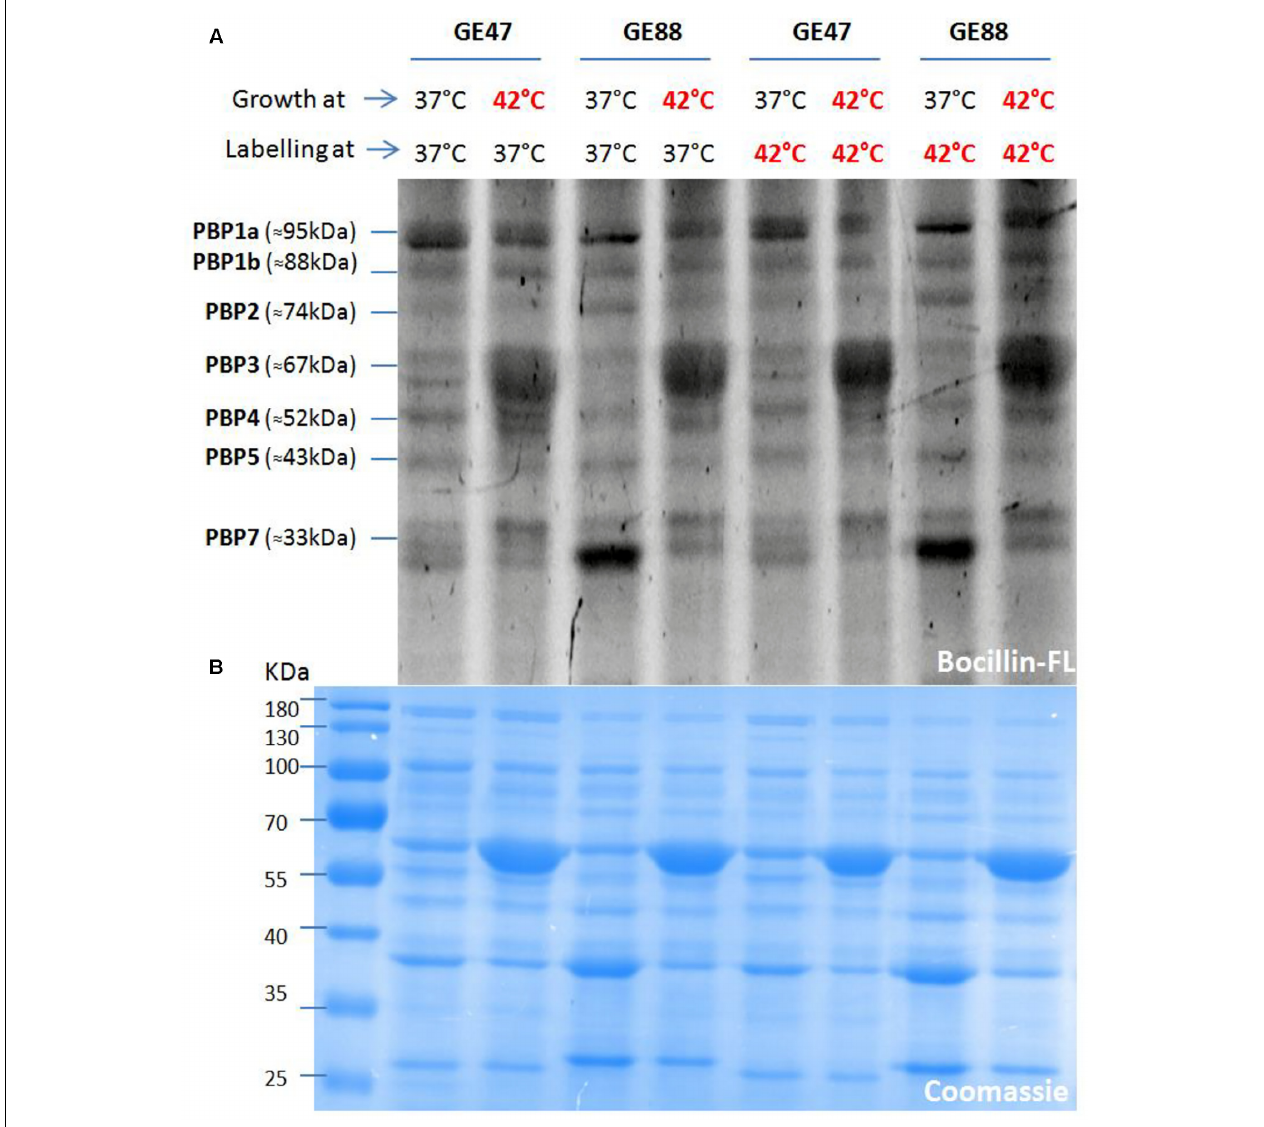
FIGURE 4 | Binding of Bocillin-FL to penicillin binding proteins (PBPs) at two different growth and labeling temperatures (37 or 42 ◦ C). (B) Shows a stained image (Coomassie) of the top gel (A) , which indicates that for both strains (GE47 and GE88) the same amounts of membrane proteins were loaded in all the